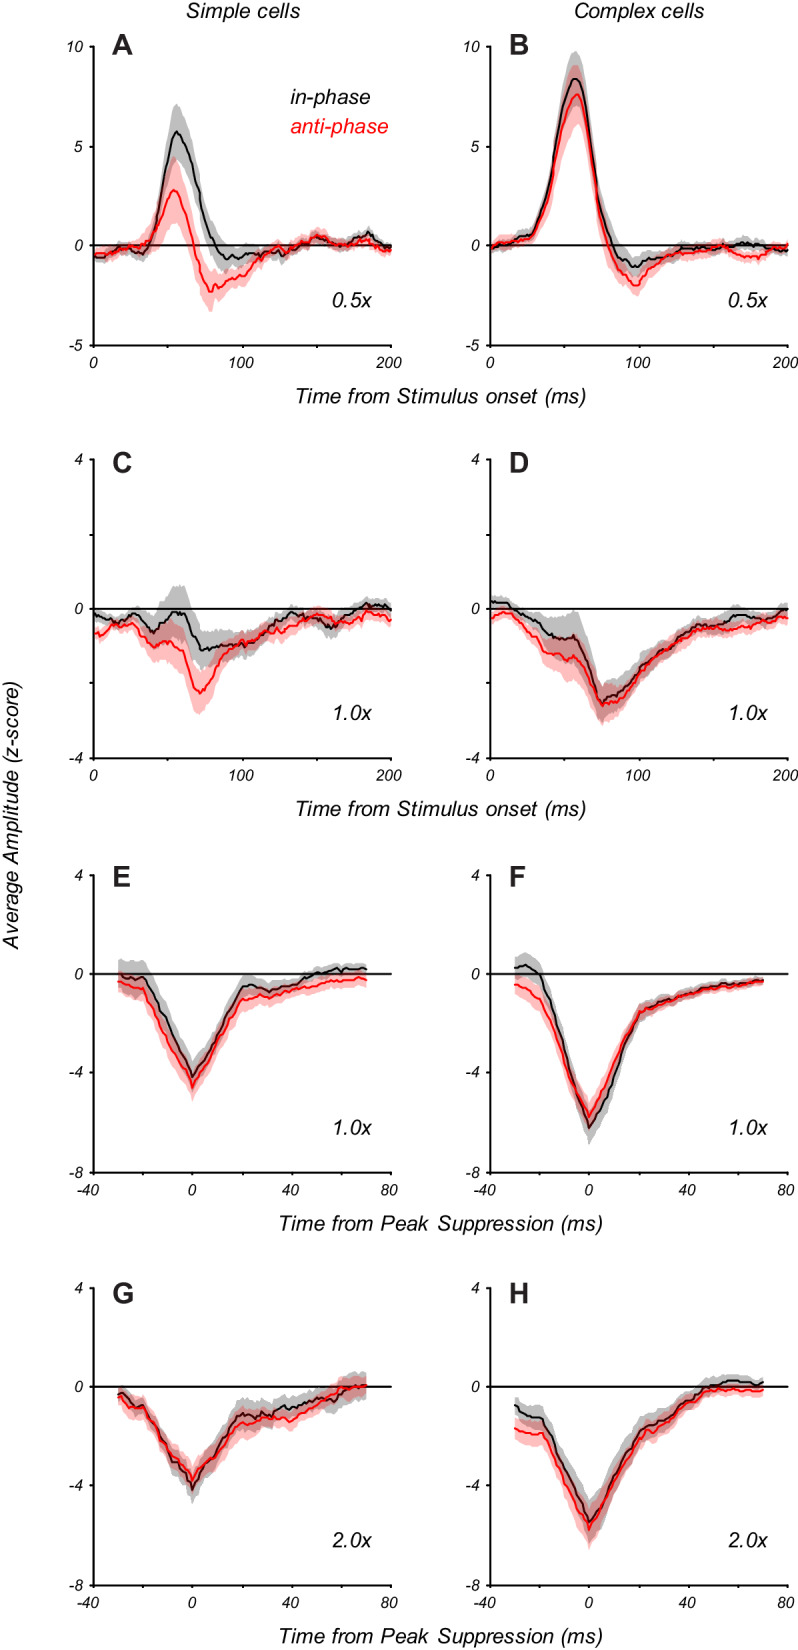
Time course of facilitation and suppression at different spatial phases of the eCRF stimulus.Response dynamics for eCRF stimuli matched in orientation to the CRF grating were split into those that were in-phase and anti-phase with the central grating, and averaged across neurons. (A) At the smallest spatial extent (0.5 x eCRF), which evokes early response facilitation, simple cells showed an increased response to in-phase eCRF stimuli (in-phase responses shown in black, anti-phase in red), presumably because of added integration within the CRF. (B) At the same scale, complex cells showed no such phase dependence. (C, D) At the large 1 x eCRF border scale, simple cells showed a slight phase dependence, whereas complex cells showed none. Suppression strength was only moderate, as the result in part of averaging over neurons with different peak times of suppression. (E, F) Traces at 1 x eCRF scale as in panels (C, D) but aligned to the time of peak suppression in individual neurons before averaging. It is clear that there is no phase-dependent suppression. (G, H) Traces at 2 x eCRF scale, aligned to the time of peak suppression. Suppression at greater extents also shows no phase-dependence.Figure 3—figure supplement 1—source data 1.Source data for Figure 3—figure supplement 1.